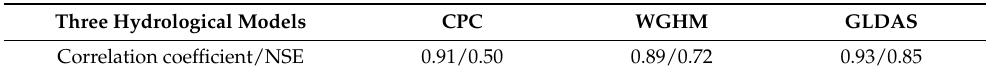
Table 2. Correlation coefficients between surface vertical deformation of water load in three filtered hydrological models and GRACE in SGN from 2010 to 2014.